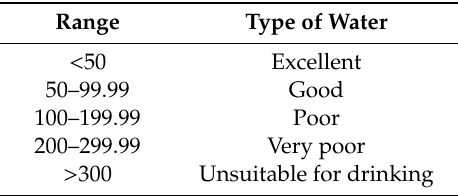
Table 2. Classification of groundwater quality according to entropy weighted groundwater quality index (EWQI)